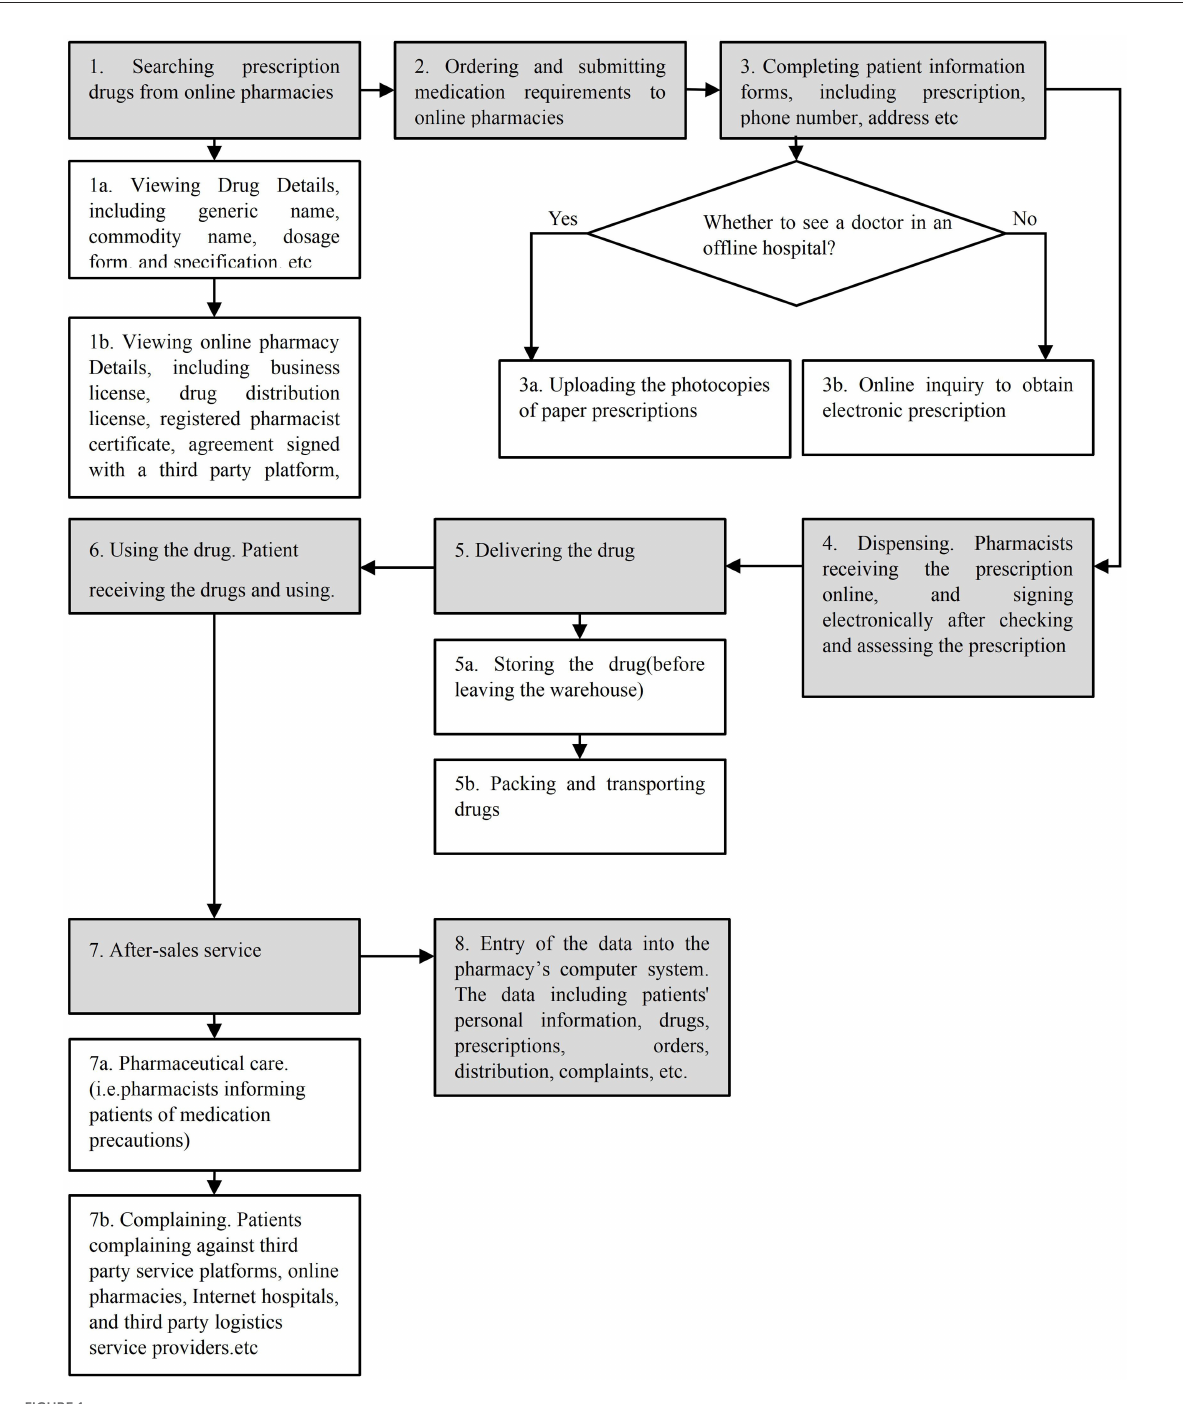
FIGURE1 Flow chart of the purchasing process for prescription drugs from online pharmacies.